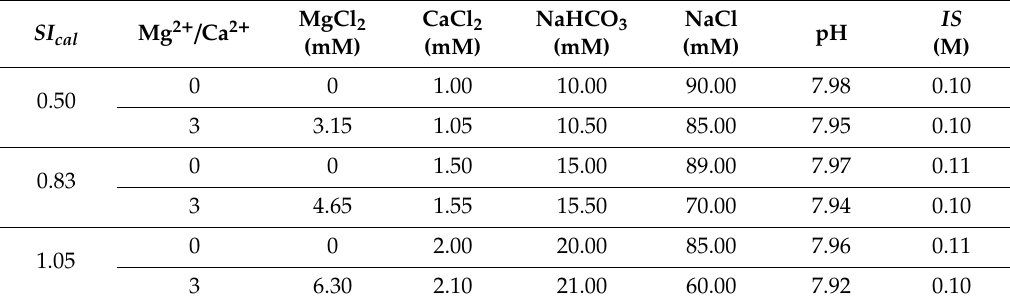
Table 1. Compositions and solution chemistry calculated by Visual MINTEQ. SI